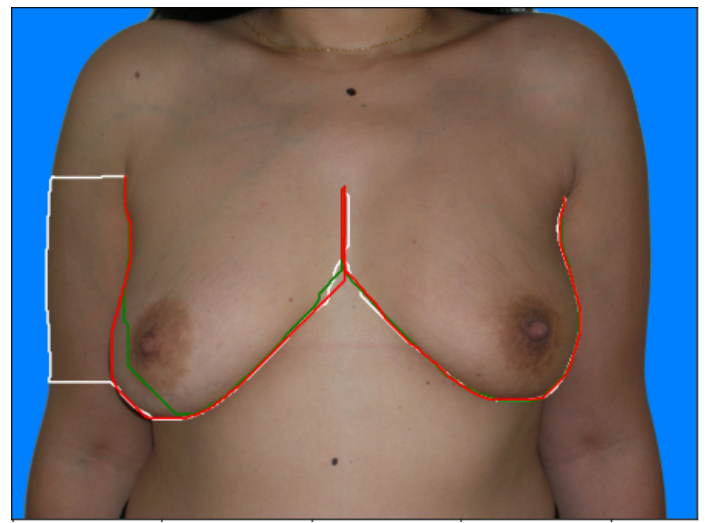
Figure 5. Original Image of Figure 4 with the shortest-path predictions using Sobel U-Net (Red line), RINDNet (Green Line) and the Sobel filter (White line).